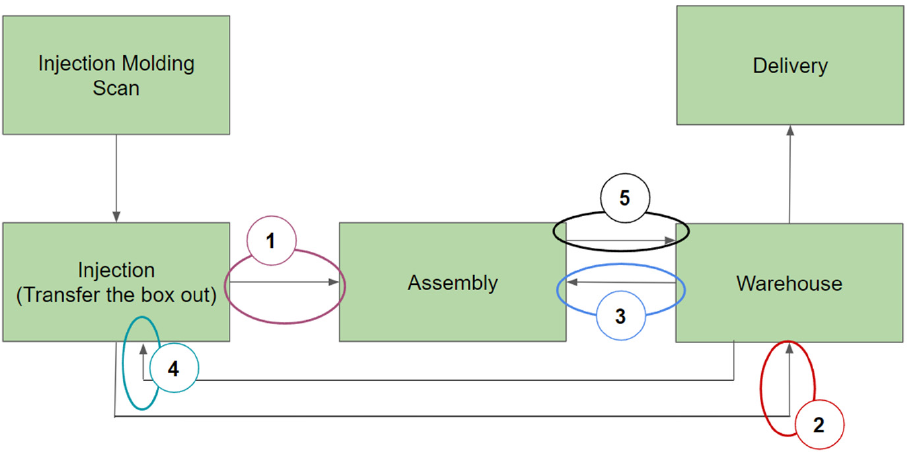
Figure 9. Illustration of in-house transit processes.